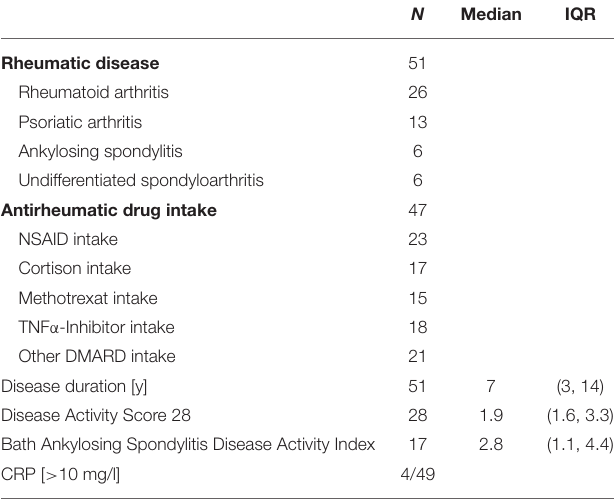
TABLE 2 | Medical record of patients with rheumatic diseases.